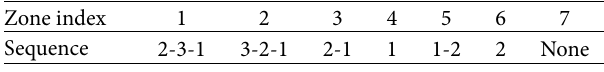
Table 3: All price-time zone SPT ordering for three orders.